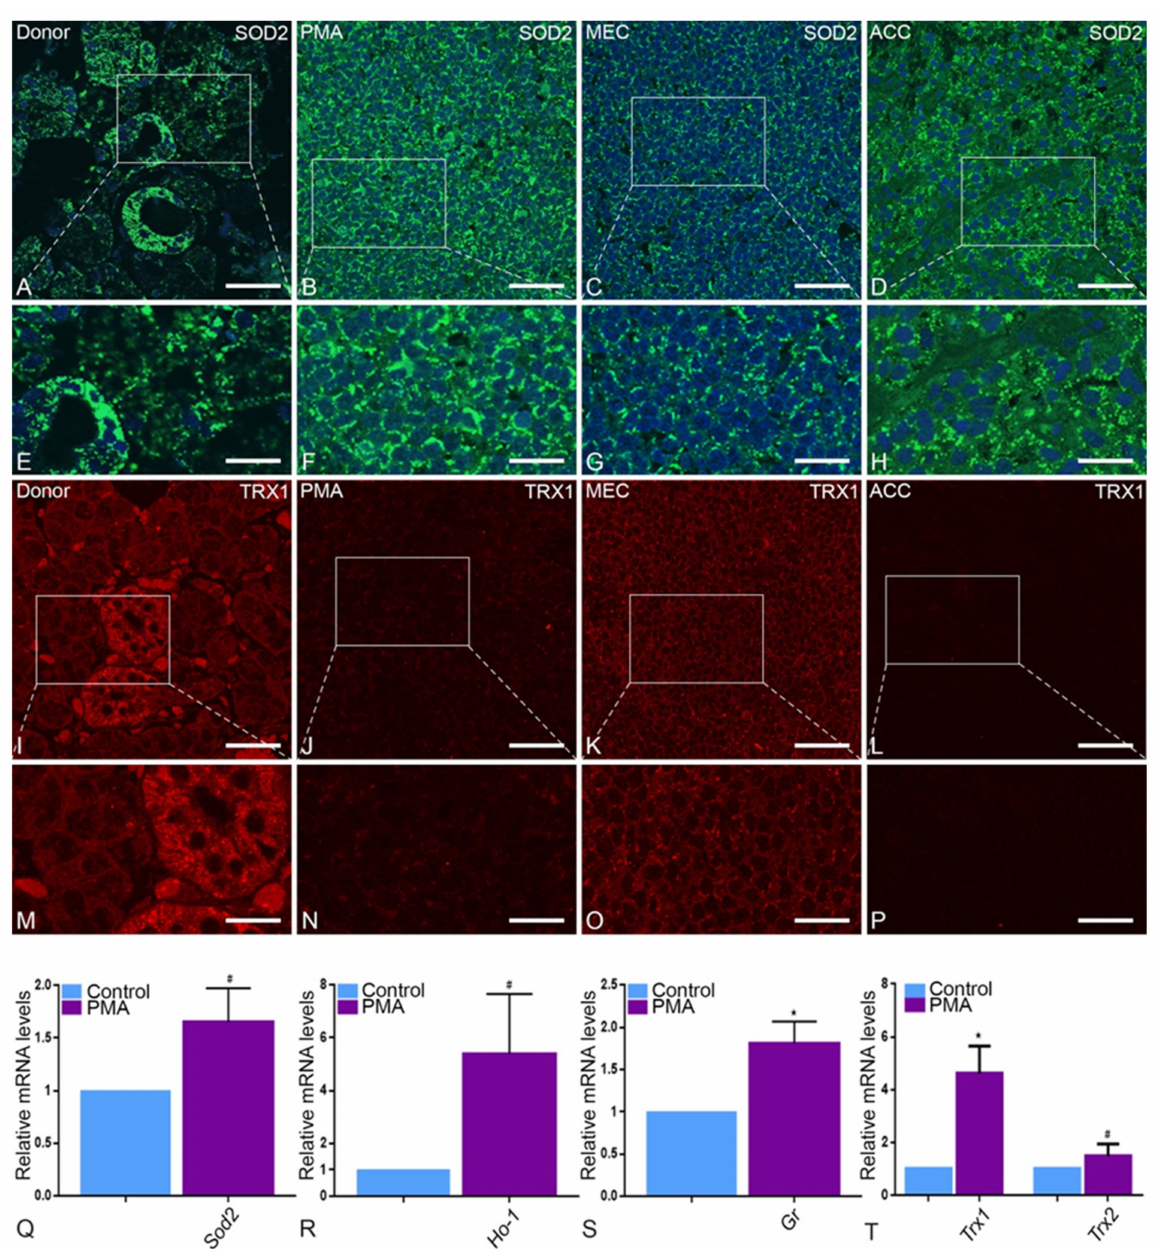
Figure 7. Anti-oxidative enzymes in PMA, MEC and ACC: In healthy parotid tissue ( A , E ), SOD2 is more abundant in striated duct than in acinar cells. SOD2 is highly expressed in PMA ( B , F ) and ACC ( D , H ). Accordingly, in real-time PCR analysis, Sod2 is significantly increased in PMA ( Q ) as well as Ho-1 ( R ) and Gr (* p = 0.034) ( S ). MEC ( C , G ) shows weak expression of SOD2. In immunofluorescence of TRX1, the control group ( I , M ) shows a strong expression especially in the striated duct cells. In addition, MEC ( K , O ) reacts positive, while PMA ( J , N ) and ACC ( L , P ) show less reaction. This contradicts the mRNA expression of Trx1 (* p = 0.0262) and Trx2 ( T ) by real-time PCR analysis. Bars represent 50 µ m: ( A – D , I – L ); 18 µ m: ( E – H , M – P ). (Explanation of the notations: The number of asterices signifies the degree of significance of the p -value, while # means not